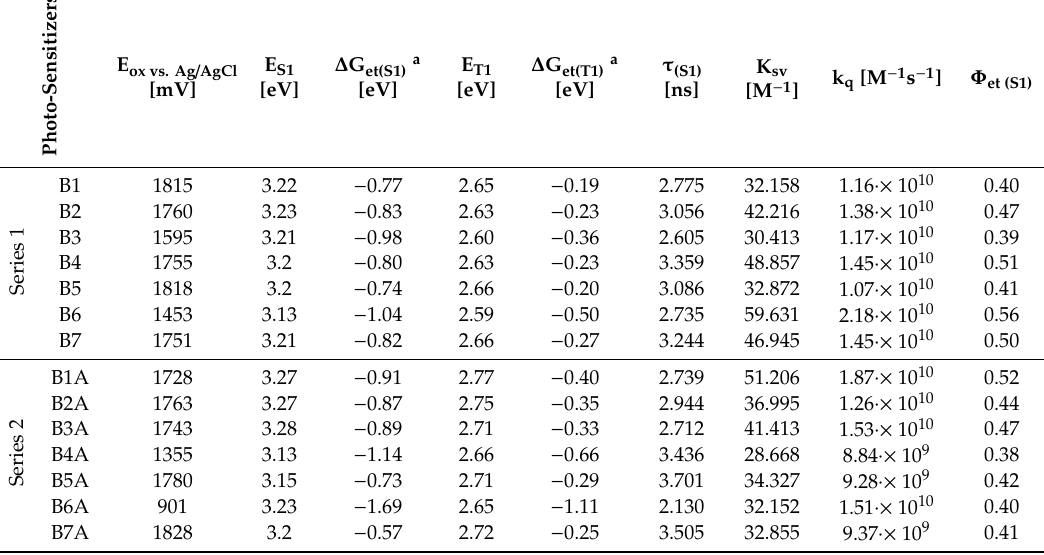
Table 3. Electrochemical and thermodynamically properties of investigated 2-amino-4-methyl- 6-phenyl-benzene-1,3-dicarbonitrile derivatives in terms of their use in photo-oxidation mechanism in light induces electron transfer